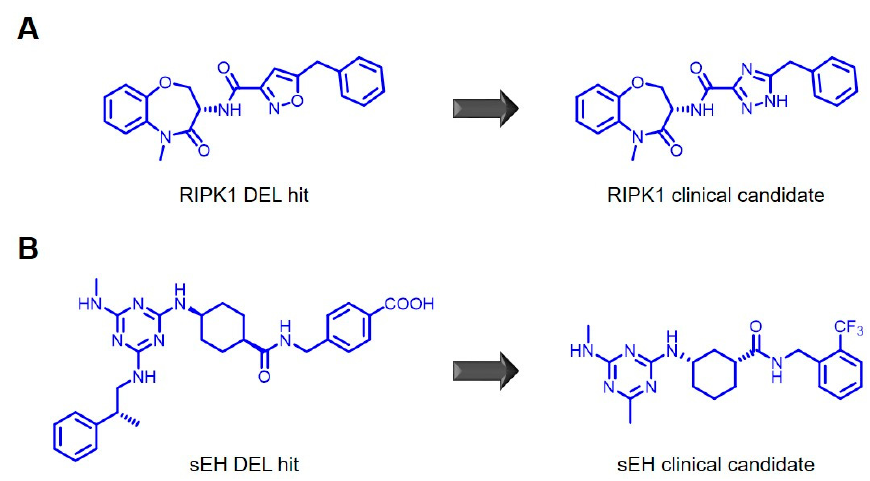
Figure 4. Chemical structures of initial hits derived from DEL screens and of the resulting clinical candidates after medicinal chemistry efforts for the two reported projects against RIPK1 ( A ) and sEH ( B ).